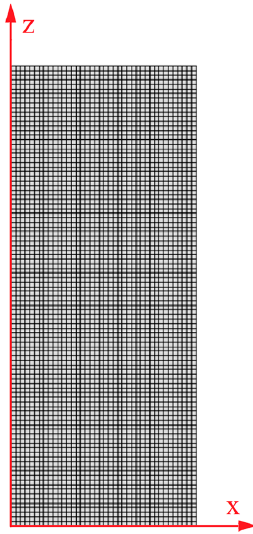
Figure 2. Mesh geometry and coordinate system.